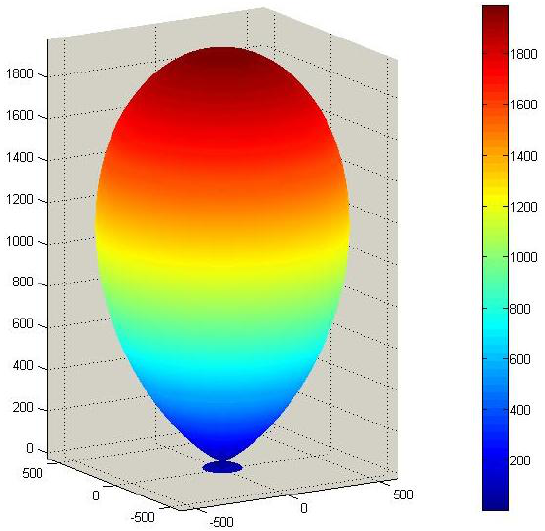
Figure 4. Longitudinal surface representation, d ( h ) (10 −12 C/N), for the piezoelectric charge constant of a PMN-PT single-crystal.